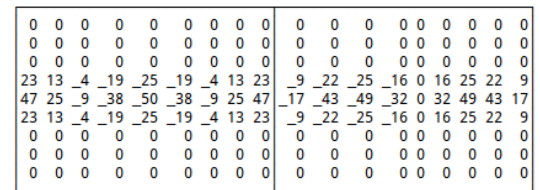
Figure 9: Convolution kernels for phase estimation of highest- frequency spatial